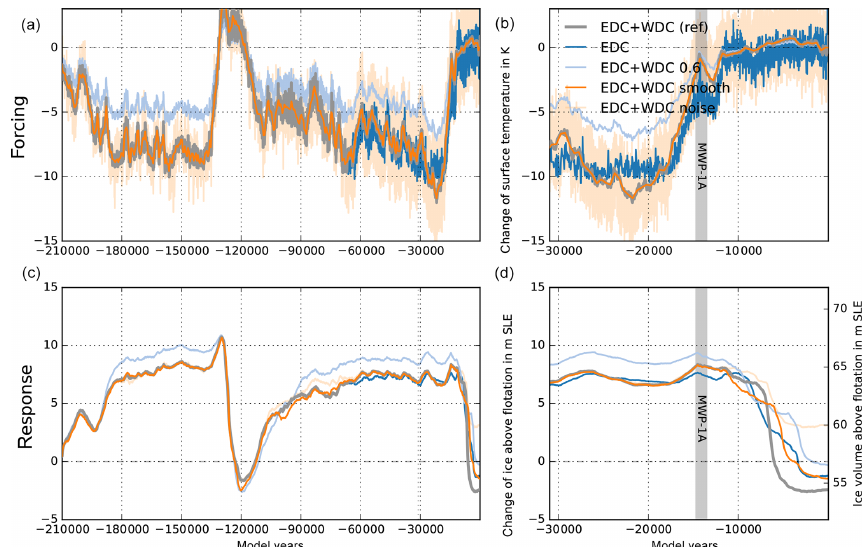
Figure 19. Time series of PISM-simulated ice volume above flotation relative to observations (Fretwell et al., 2013) over last 135kyr (c) and last 31kyr (d) forced with different surface temperature reconstructions (a, b) at WDC (Cuffey et al., 2016, grey) and EDC (Jouzel et al., 2007, blue), leading to different ice volume histories, particularly during deglaciation period. The WDC temperature reconstruction scaled by 60% causes 2mSLE larger glacial ice volume and slower deglaciation (light blue). When WDC temperature reconstruction is smoothed, we find a slightly earlier initial retreat (orange), while added white noise leads to higher ice volume at present (light